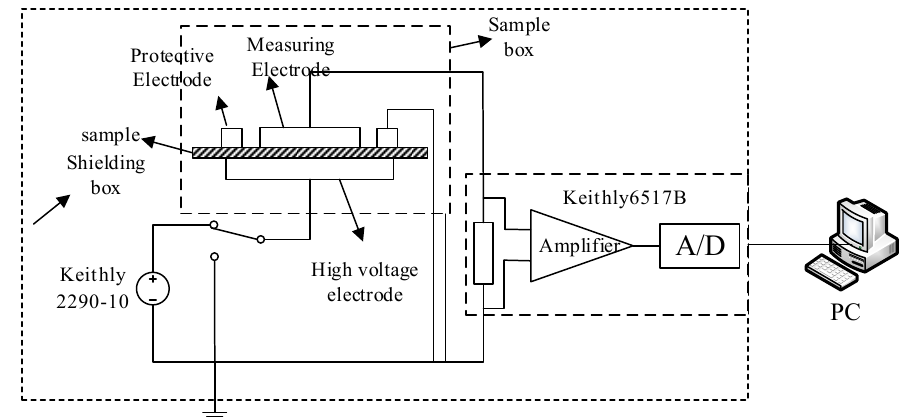
Figure 1. Hardware structure of the polarization and depolarization current testing system.